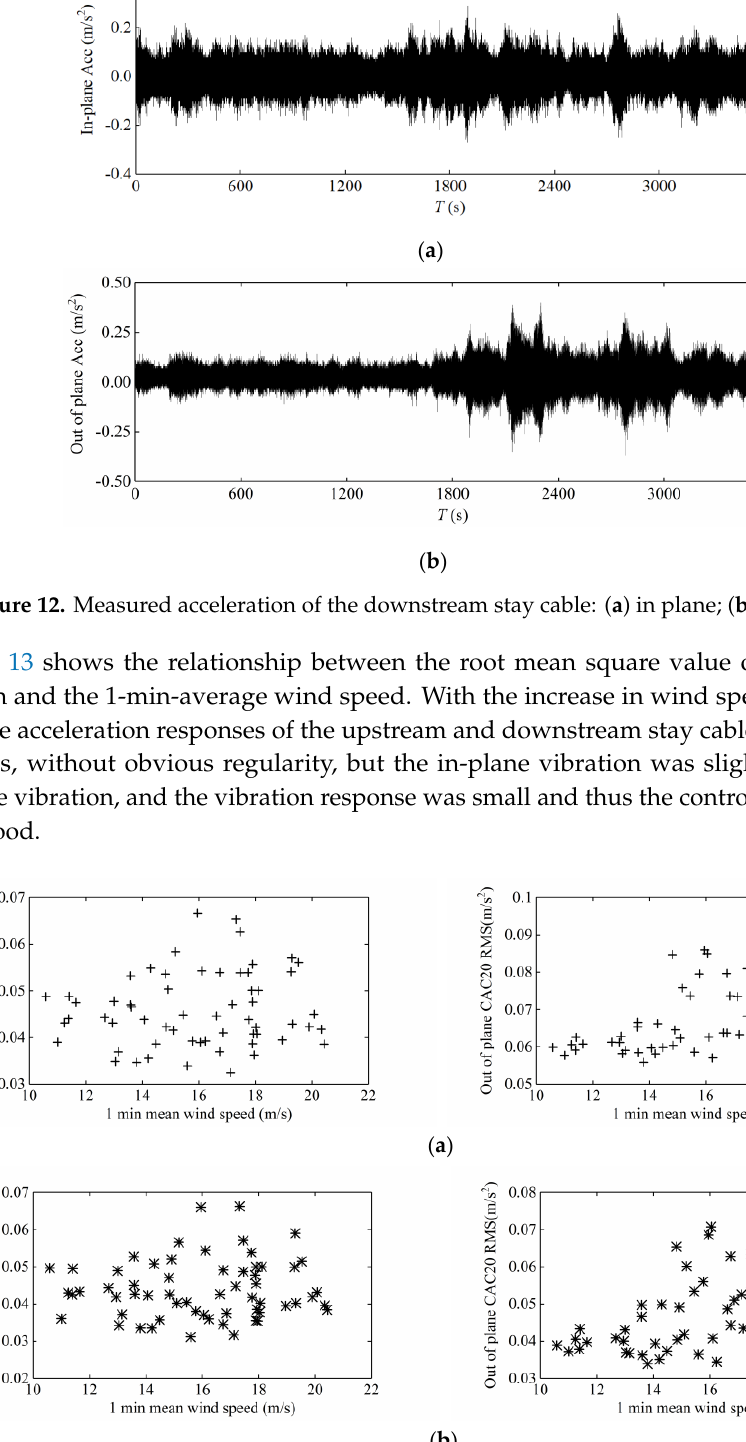
Figure 11. Measured acceleration of the upstream stay cable: ( a ) in plane; ( b ) out of plane.